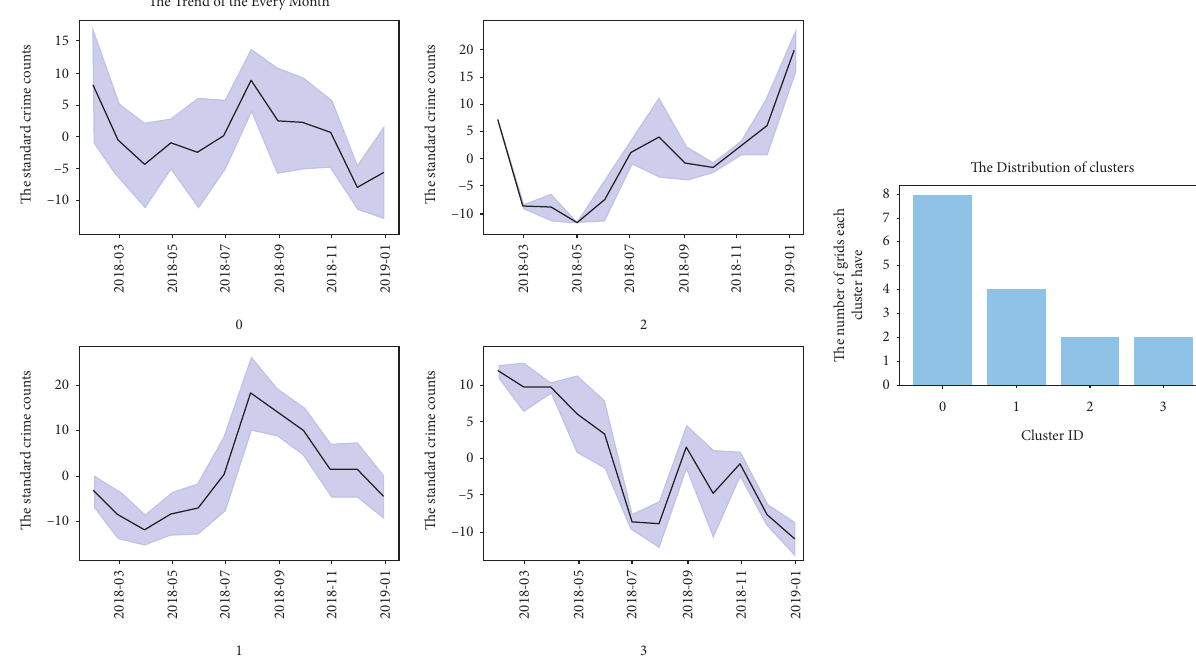
Figure 10: The theft in San Francisco trends in each month in 2018 and the distribution of clusters. The line charts are the monthly trends of theft in San Francisco in 2018. The bar chart is the distribution of the